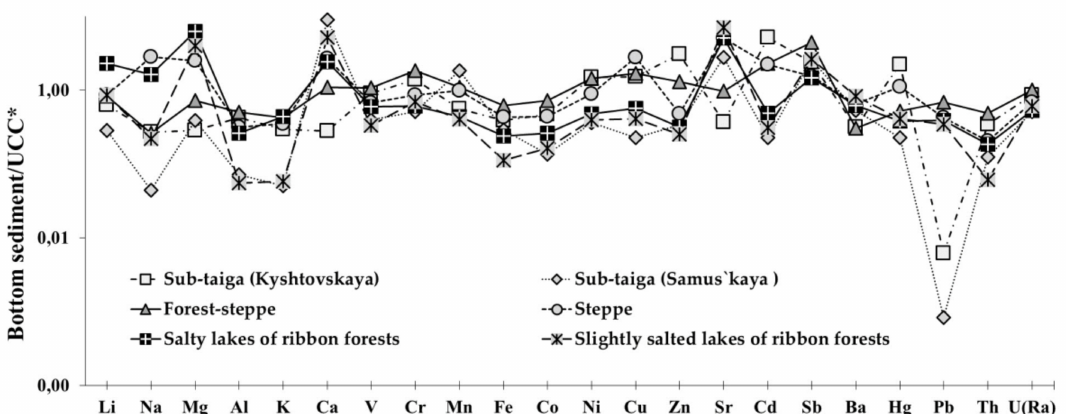
Figure 4. The multi-element spectrum of the average values of the studied elements for bottom sediments of lake systems in the south of Western Siberia normalized to the values of the upper continental crust concentrations according to Wedepohl, K.H.